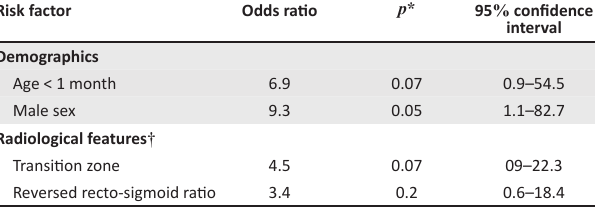
TABLE 3: Risk factors for the disease adjusted for age and sex. Risk factor